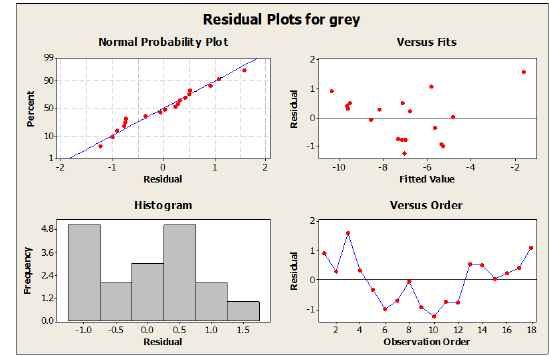
Fig. 2. Effects of Process Parameters on R